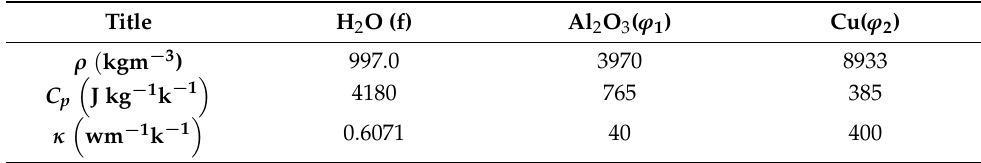
Table 2. Thermophysical properties of base fluid and NPs